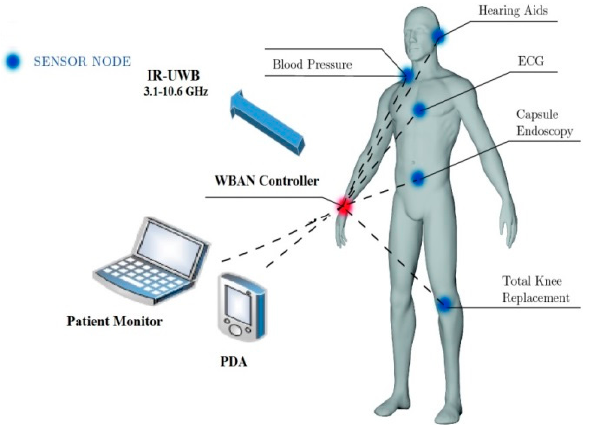
Figure 8. UWB technology in wireless body area networks [43].